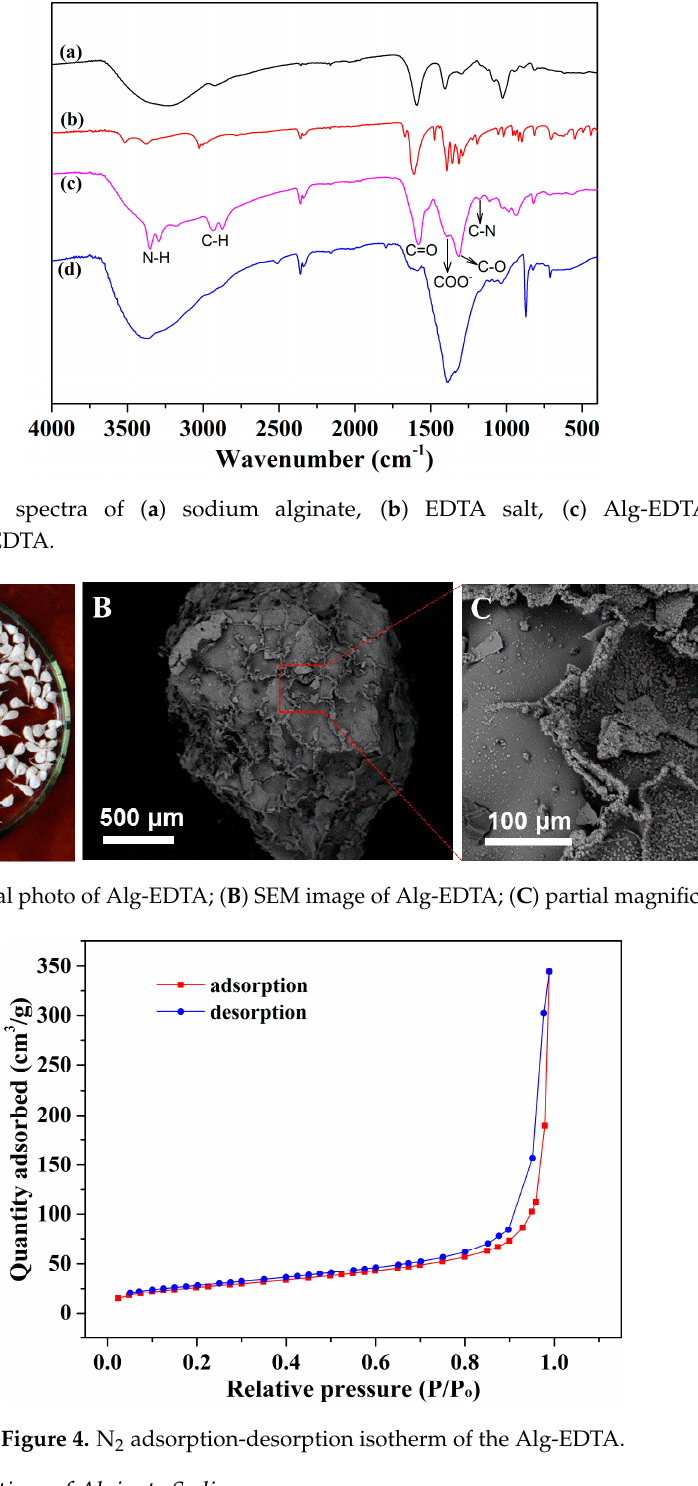
Figure 4. N 2 adsorption-desorption isotherm of the Alg-EDTA.